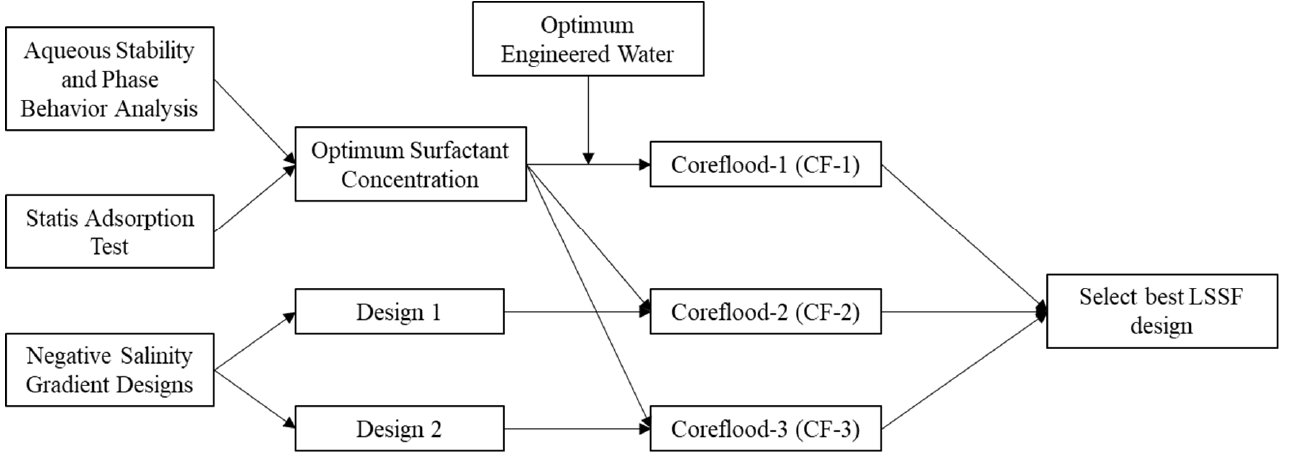
Figure 1. Flow chart showing main steps involved in the research design for the selection of best LSSF scenario.